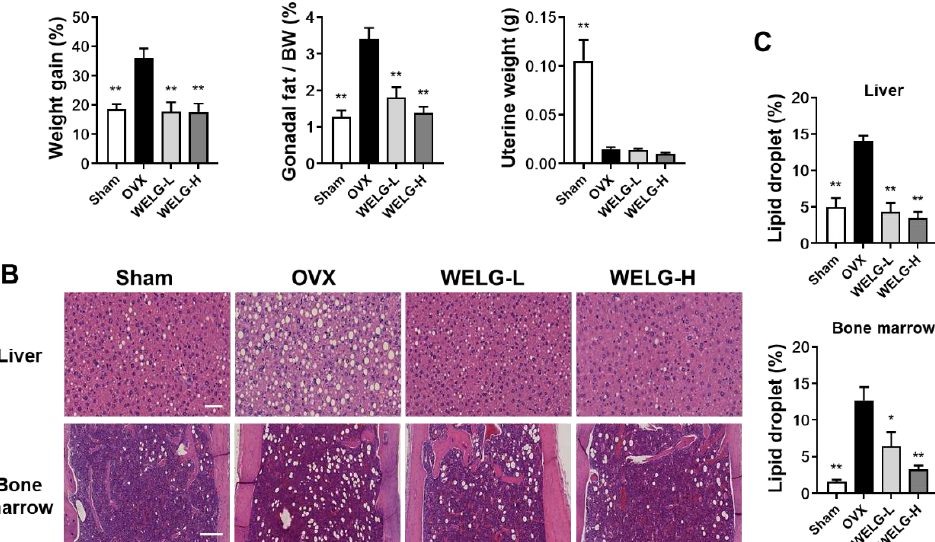
Figure 5. Inhibitory effect of WELG administration on OVX-induced fat accumulation. Mice were orally administered distilled water, WELG-L (100 mg/kg; Low), or WELG-H (300 mg/kg; High) for 6 weeks beginning 1 week after OVX or sham surgery. ( A ) Measurement of body weight changes for 7 weeks, gonadal fat weight/body weight (BW), and uterine weight. ( B ) Representative images of hematoxylin- and eosin-stained liver (scale bar, 50 µ m) and bone marrow (scale bar, 200 µ m) sections. ( C ) Quantification of lipid droplets in the liver and bone marrow sections. * p < 0.05, ** p < 0.01 versus OVX group. OVX